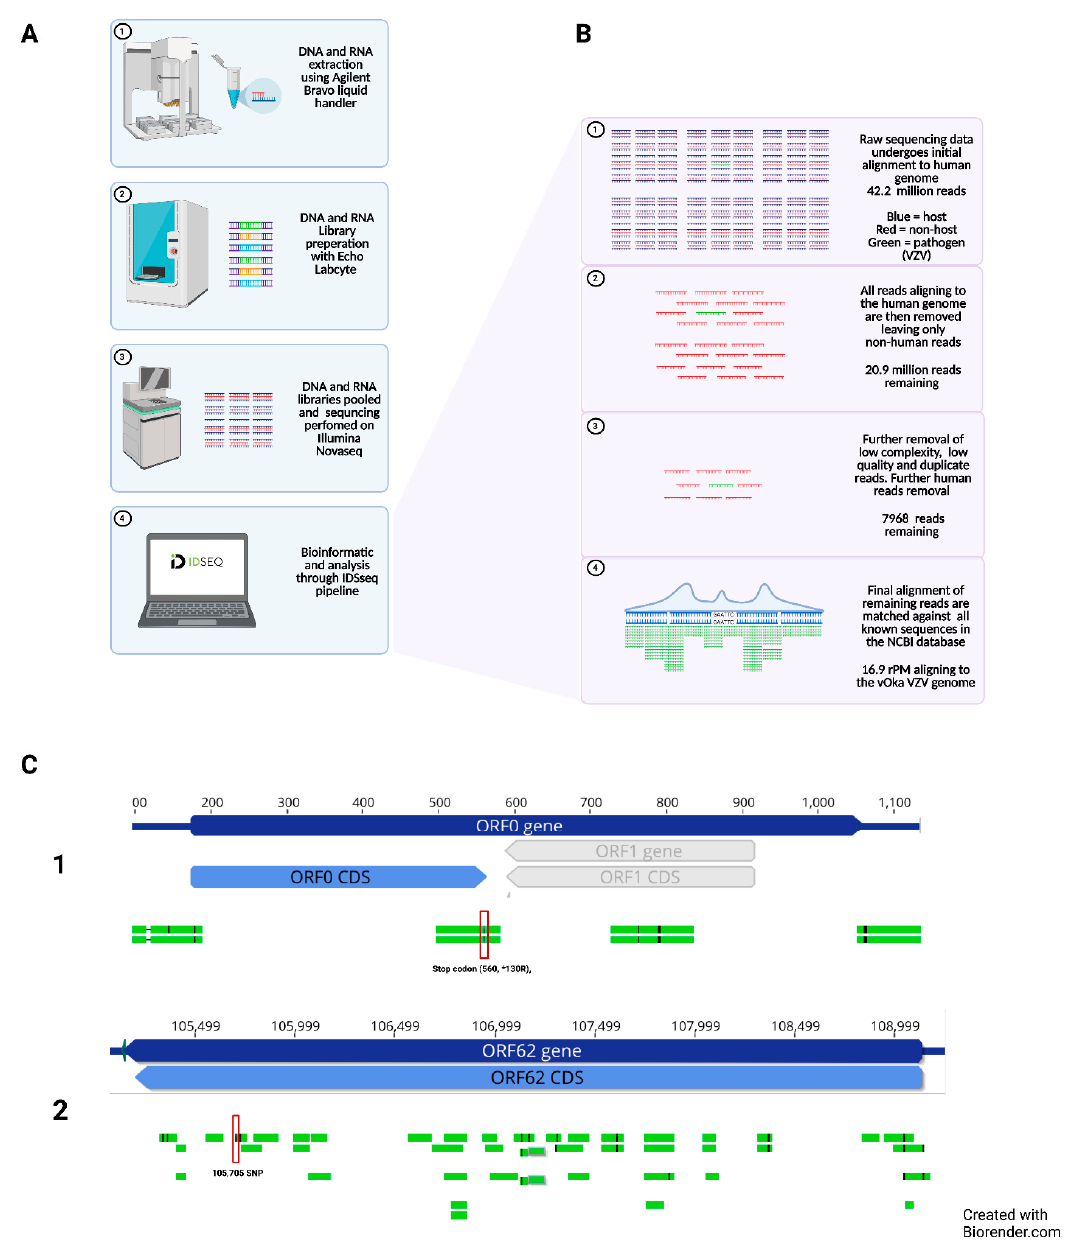
Figure 1. Identification of varicella vaccine virus DNA in CSF by mNGS. ( A ) Overview. Samples were processed on liquid handling robots; initially nucleic acid was extracted, and DNA and RNA underwent library preparation before being pooled and sequenced on the Illumina Novaseq at a sequencing depth of 42.2 million reads. Sequencing data were then analyzed using the open source IDseq pipeline. ( B ) Individual steps. The pipeline matched all data against the human genome, with removal of human reads (blue). Remaining non-host reads (red) underwent quality processing with the removal of redundant, low quality, and low complexity reads. The remaining reads were matched against the NCBI database for potential pathogens, with 16.9 rPM matching to the VZV genome (green). ( C ) VZV genes. Further analysis found 8 reads aligning with the ORF0 reference gene (panel C1 ) and 44 reads with the ORF62 reference gene (panel C2 ). Black lines within the reads (green) represent nucleotide mismatches or single nucleotide polymorphisms against the reference genome (blue). DNA, deoxyribonucleic acid; RNA, ribonucleic acid; VZV, varicella zoster virus; vOka, vaccine strain; ORF, open reading frame; CDS, CoDing Sequence.